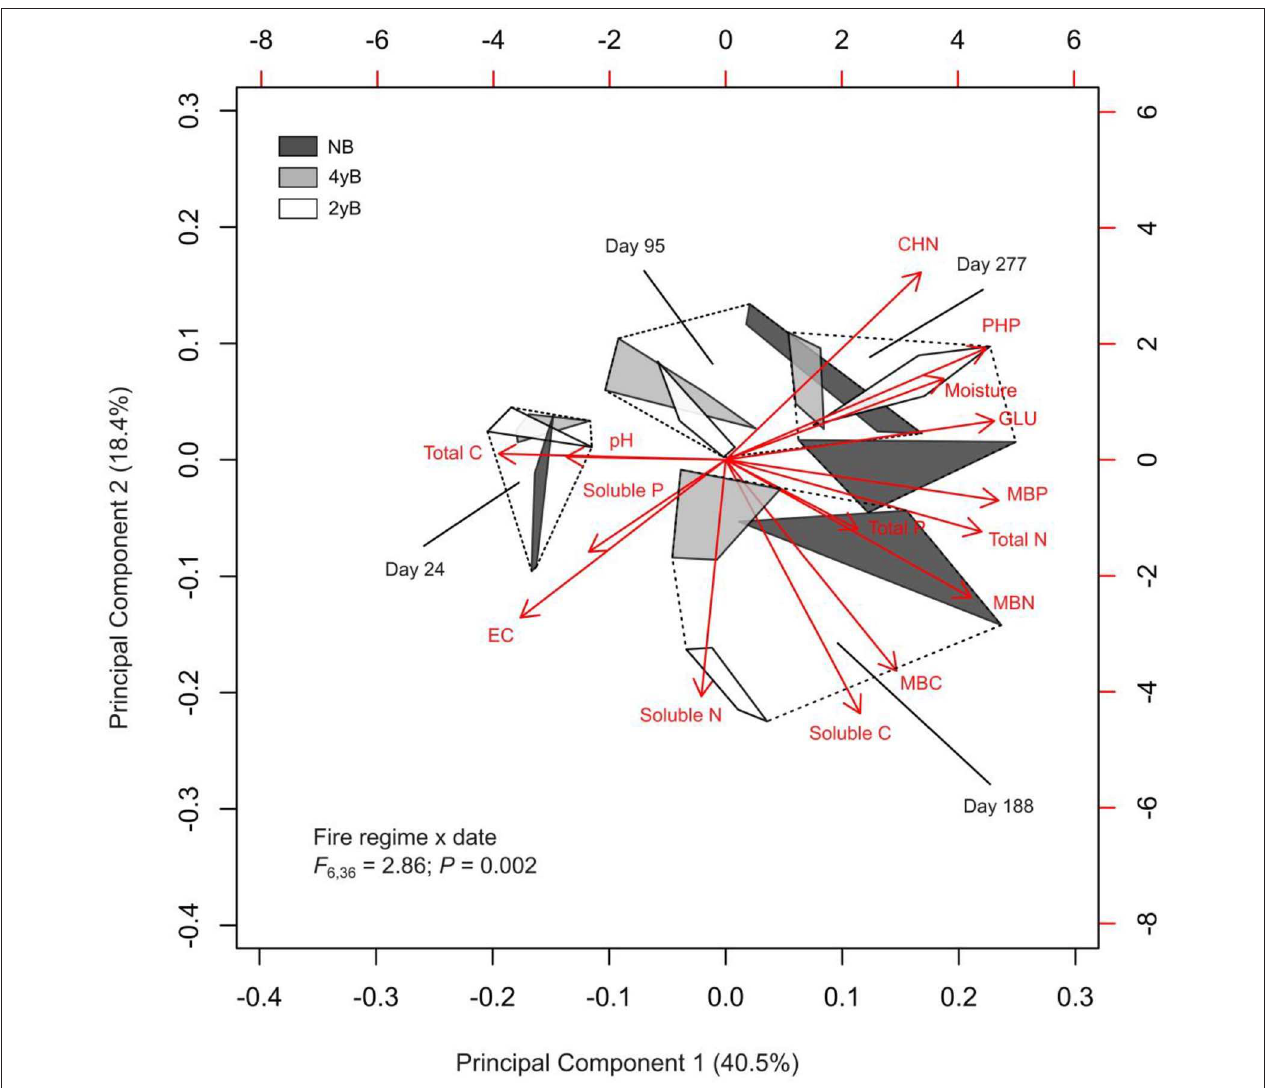
FIGURE 8 | Biplot generated from Principal Component Analysis of chemical and biological properties of Eucalyptus pilularis leaf litter during 277-days of decomposition, with hulls based on fire regime treatment; statistics for fire regime by date interaction from factorial permutational analysis of variance